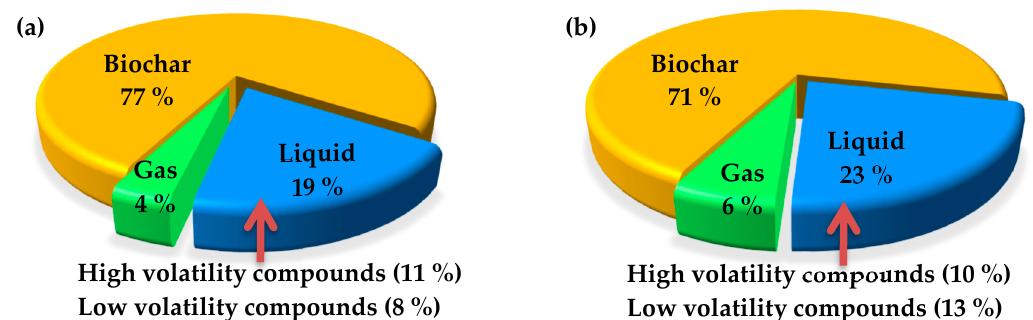
Figure 6. Energy distribution of biomass sources torrefied at 300 °C for 60 min in ( a ) nitrogen and ( b ) vacuum. Table 5. HHVs of untreated and torrefied biomasses.